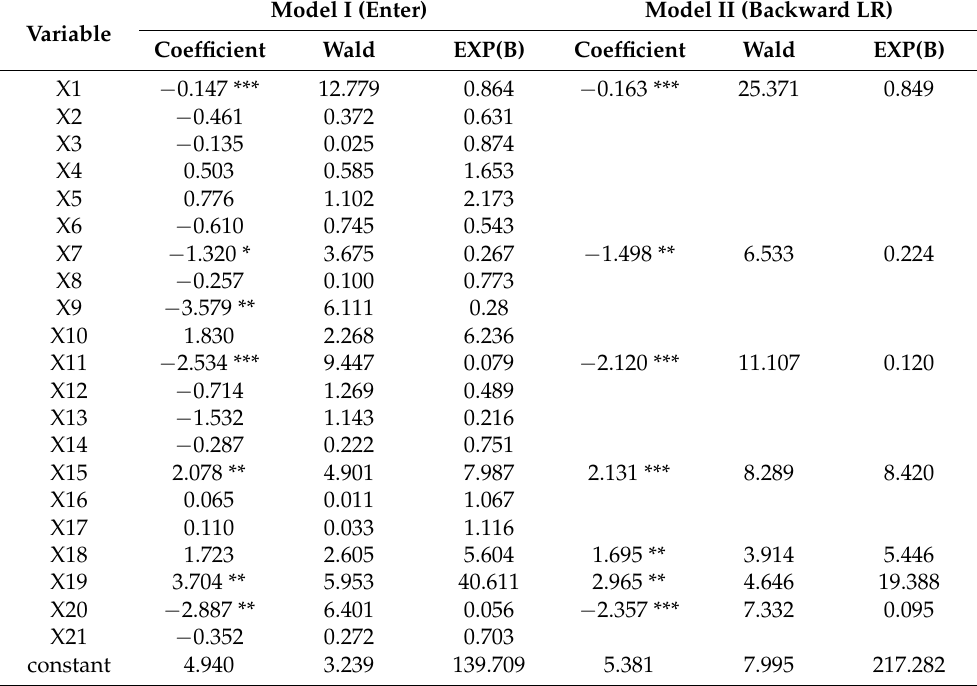
Table 4. Regression results of the logistic